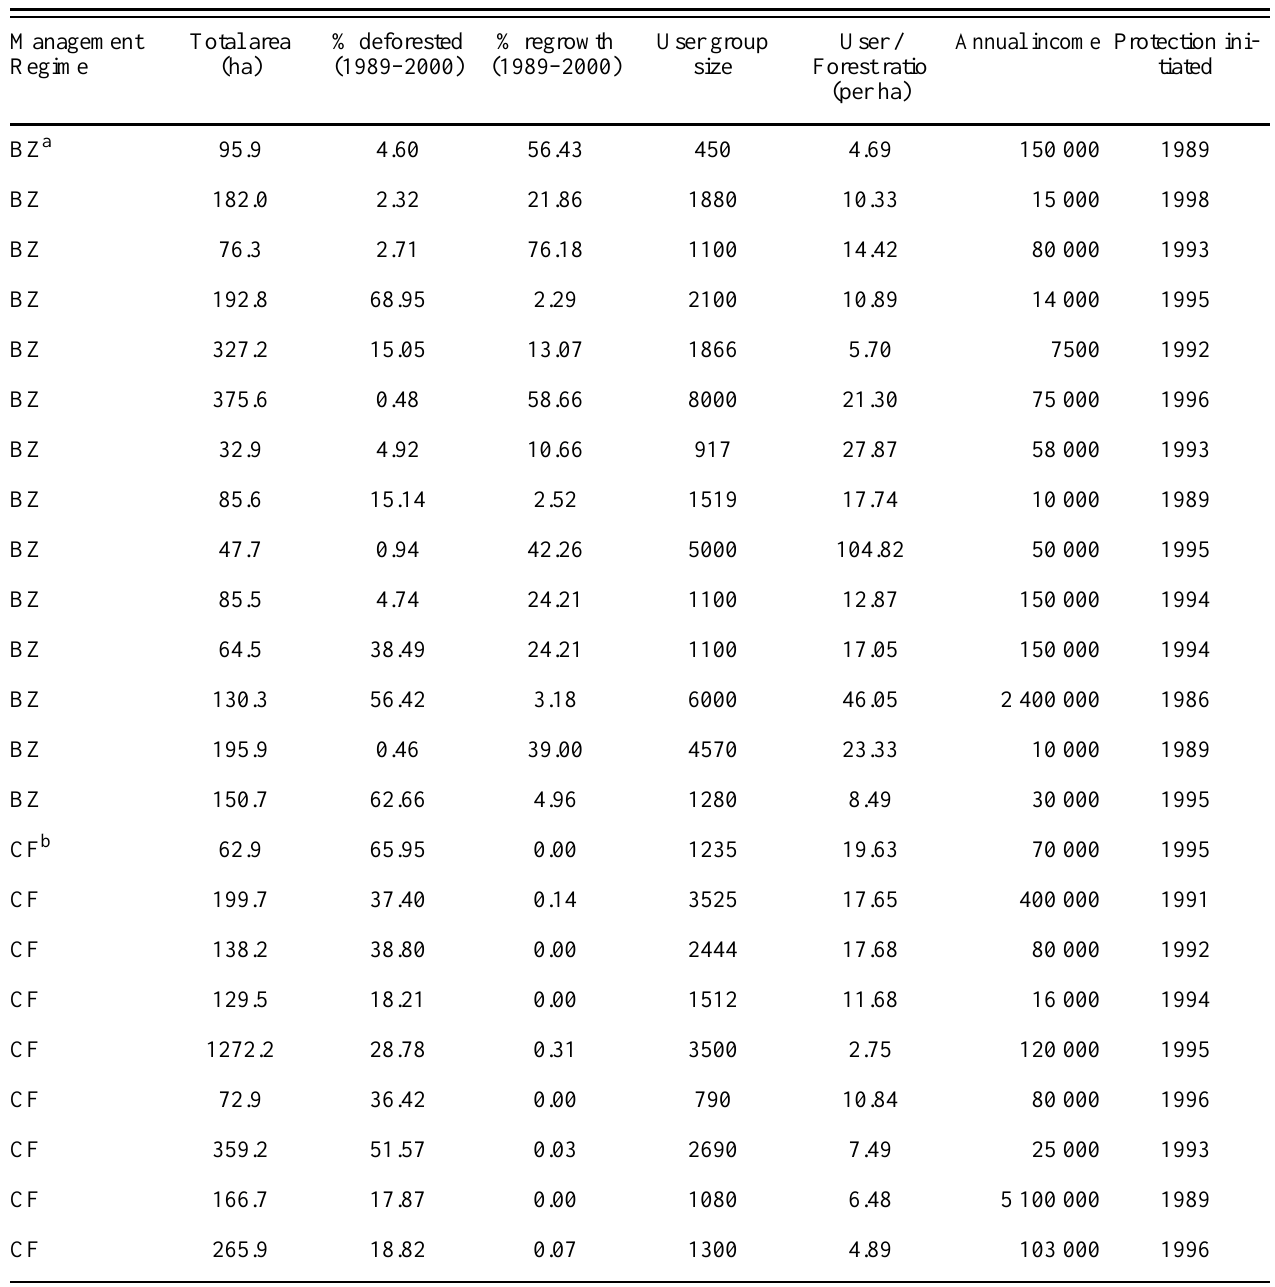
Table 2. Description of study forests Management